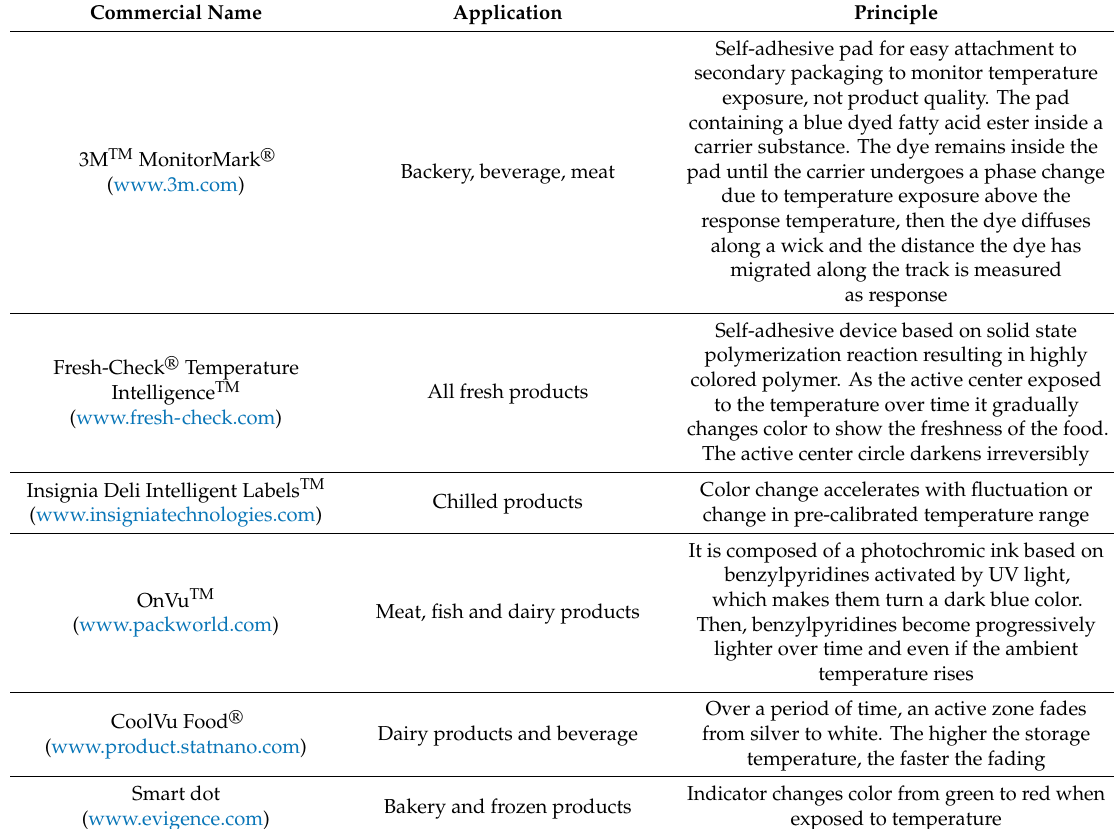
Table 4. Commercially available time-temperature indicators (TTI)